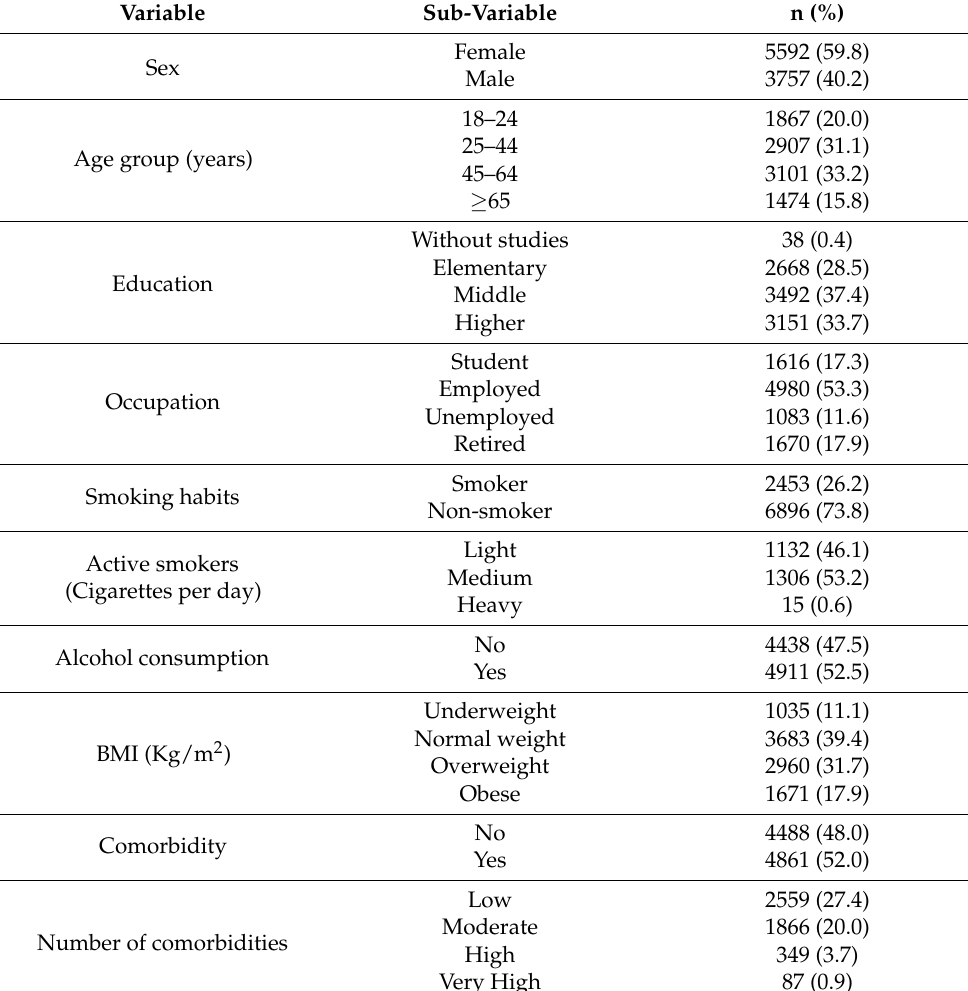
Table 1. Sociodemographic, health, and behavior characterization of the participants (n = 9349).